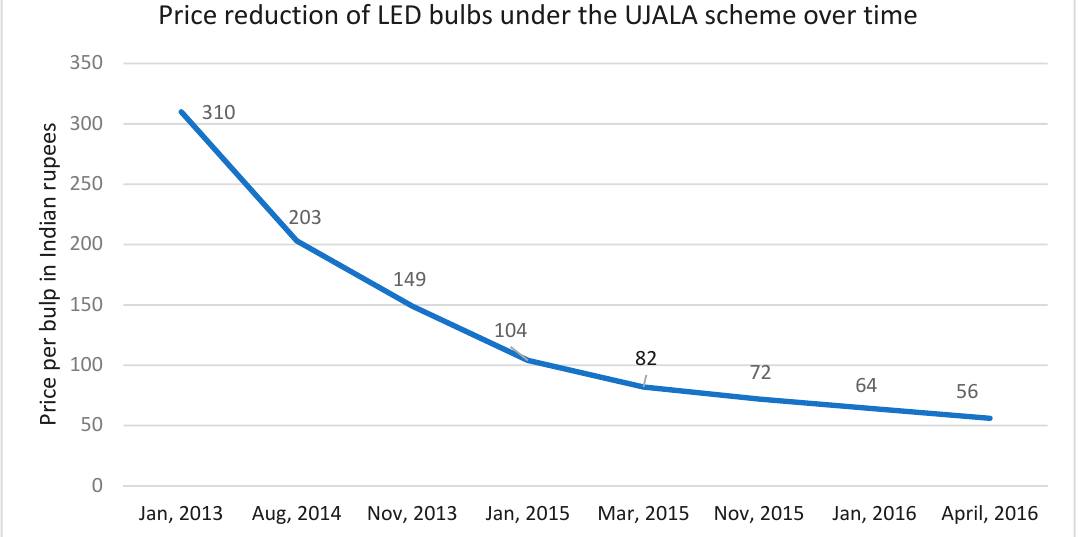
Figure 1. Price drop for LED lamp in India under the UJALA scheme. Graph based on data in [42].